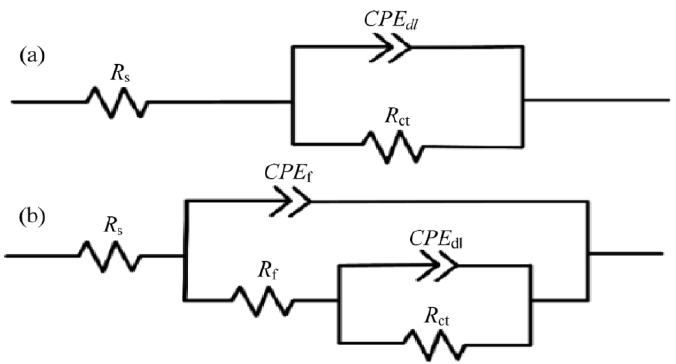
Figure 34. Equivalent circuit models matched to the EIS plots of: ( a ) NiTi − I and ( b ) NiTi − II and NiTi − III samples (Reprinted with permission from Ref. [63]. 2021, Yang, C.J.).